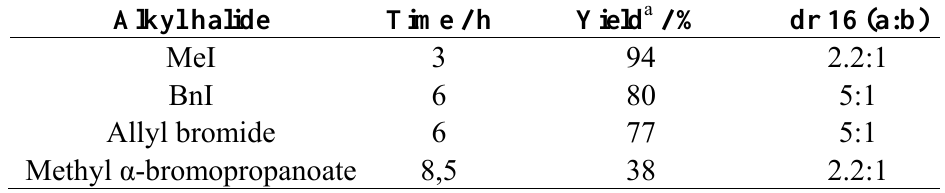
Table 1. Diastereoselectivity in regioselective